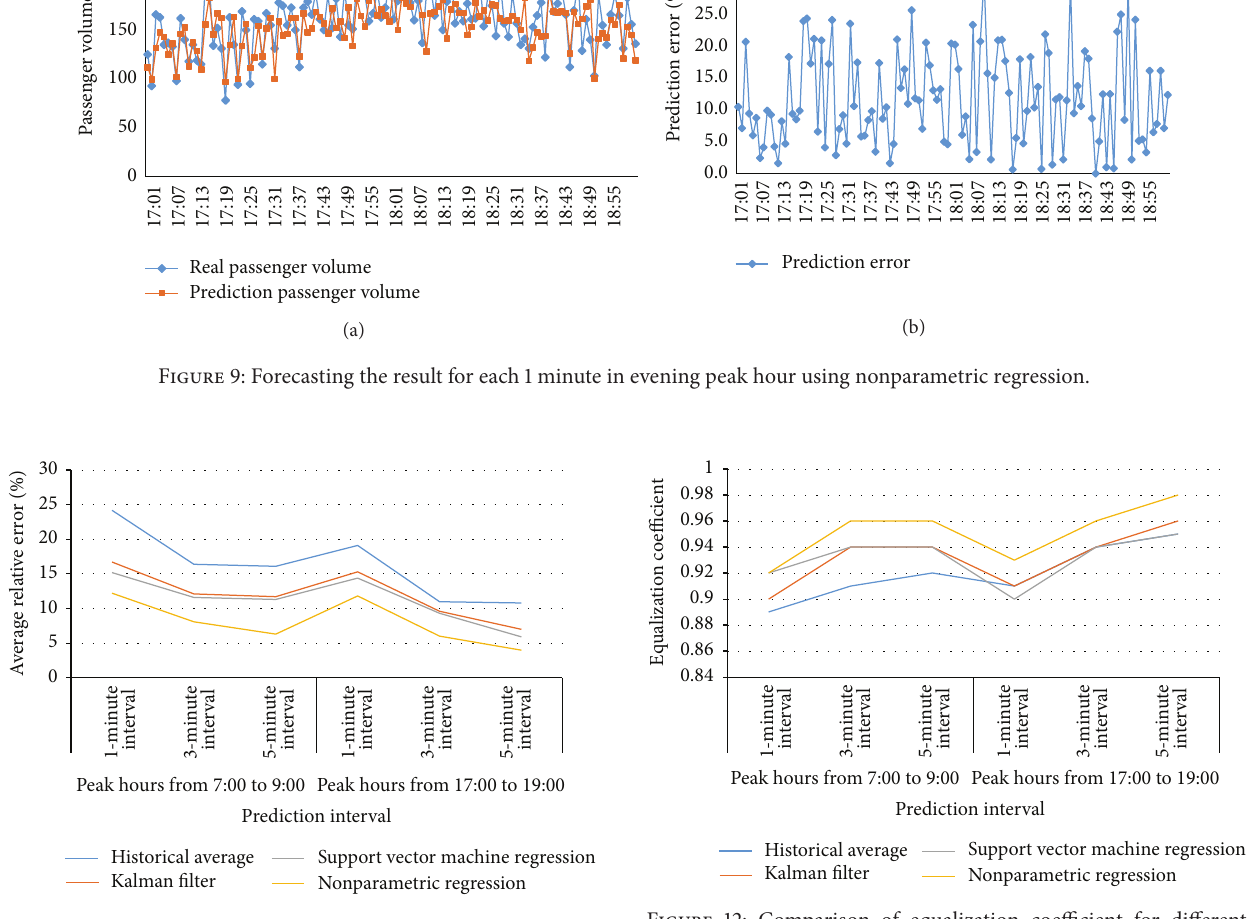
Figure 10: Comparison of average relative error for different forecasting models.